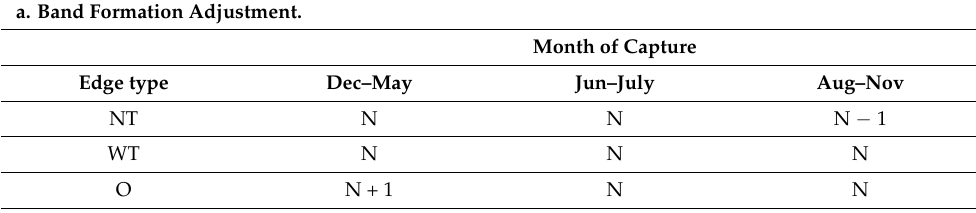
Table 2. ( a – c ) To convert opaque band counts (N) into age estimates (A) following the ageing protocol of Rodriguez-Marin et al. [11] the following two-step age adjustment should be used: (1) Based on otolith marginal edge type (NT = narrow translucent, WT = wide translucent or O = opaque), the adjustment date of 30th November and the date of capture ( a ). And (2) June 1st for the biological adjustment ( b ) or January 1st for the calendar year adjustment ( c